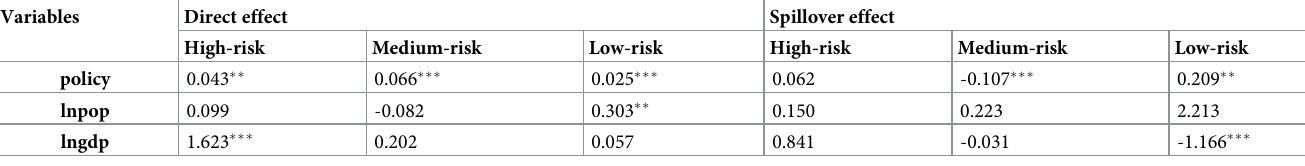
Table 8. Empirical results of decomposition of spatial effect based on the asymmetric weight matrix.